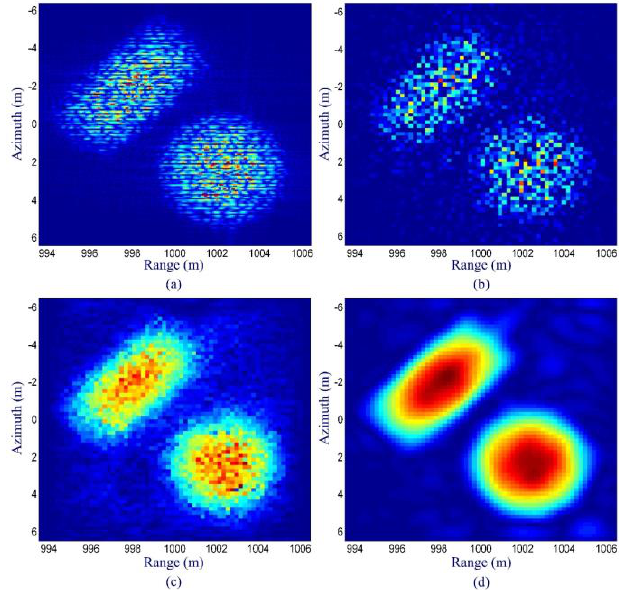
Figure 10. ( a ) Magnitude of the scene, ( b ) phase of the scene, ( c ) DCT result of the magnitude (taken from [79]). Sensors 2019 , 19 , x 12 of 19